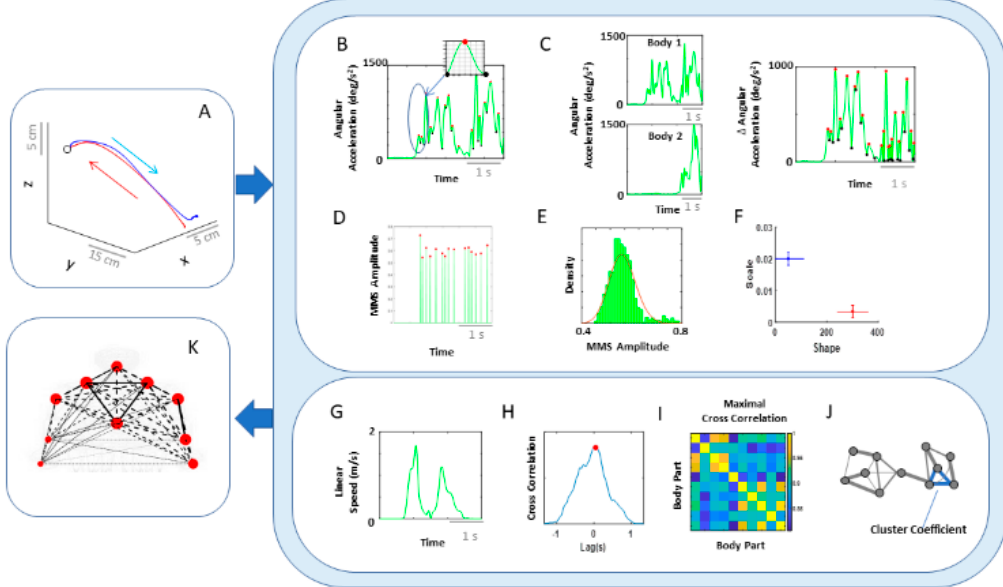
Figure 4. Analytical pipeline and visualization methods for the kinematics network. ( A ) Representative movement trajectory of the performing hand during a pointing motion to a target (denoted by a small open circle). Each trial was comprised of a forward–deliberate (red) and backward–spontaneous (blue) segment. These could be automatically separated by the speed and distance criteria (see Figure A2). ( B ) Time series of angular acceleration of the performing hand’s index finger during a typical pointing task. To examine kinematics-based connectivity, we used the angular acceleration time series, focusing on the moment by moment fluctuations in waveform amplitude. Here, peaks (maxima) and valleys (minima) are shown in red and black dots, respectively. The inset shows a zoomed-in picture of a single angular acceleration segment (i.e., two local minima and a single peak in between, used for standardization described in Equation (1). ( C ) Pairwise absolute di ff erence in waveform was obtained and standardized using Equation (1). The resulting waveform provided the input to obtain MMS. ( D ) MMS train scaling the waveform amplitude for a typical pointing task. All standardized spike amplitude values from ( B ) and ( C ) were maintained, while all non-spike values were set to 0. ( E ) Frequency histogram of MMS amplitudes fitted to a Gamma probability distribution function (PDF) using maximum likelihood estimation (MLE). ( F ) The empirically estimated Gamma parameters (shape and scale) were obtained and plotted on a Gamma parameter plane, with marker lines representing the 95% confidence interval. Noise-to-signal ratio (NSR) (i.e., fitted Gamma scale parameter) were later used for comparison between motor segments and di ff erent performing side. ( G ) Representative time series of linear speed of the performing hand’s index finger in one trial. ( H ) Pairwise cross-correlation between two body parts. ( I ) Adjacency matrix obtained from all pairwise maximal cross-correlation across all body parts under consideration, to represent a weighted undirected graph. ( J ) Connectivity metrics (e.g., clustering coefficient) were used to quantify patterns of temporal dynamics. ( K ) Network connectivity analyses to unveil self- emerging clusters, where nodes correspond to each body part. For the spatial domain, NSR derived from MMS amplitudes of angular accelerations were visualized as node size, and NSR derived from MMS amplitudes of pairwise absolute difference in angular acceleration as edge thickness. For the temporal domain, cluster coefficients were visualized as node size, and median cross-correlations as edge thickness. For the connectivity analysis centered on spatial aspects of the signal amplitude, we pooled the angular acceleration data from each body part and extracted the MMS amplitudes (referred to as